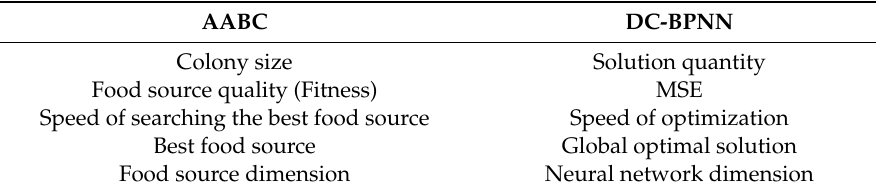
Table 2. Corresponding relations between the AABC and